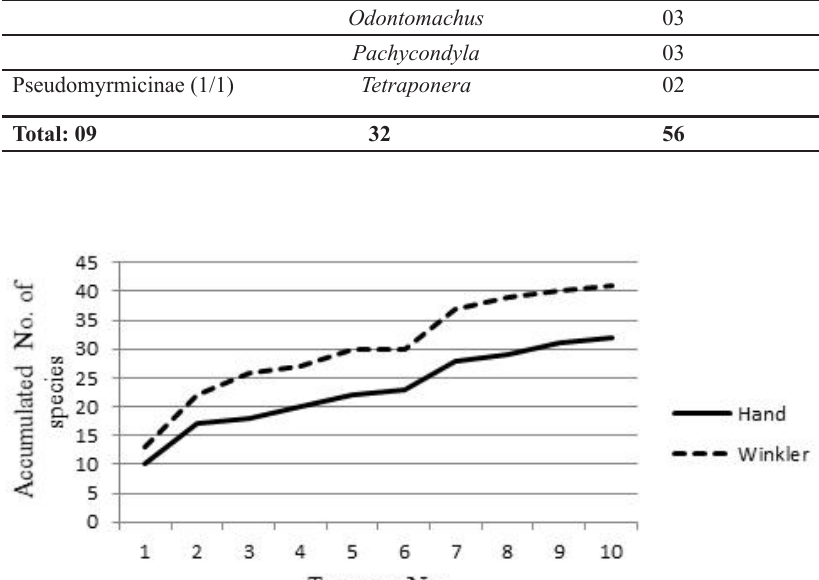
Figure 1: Species accumulation curves for the ants collected from the hand picking method and Winkler extraction method along the 10 transects installed along an elevation gradient in the Hanthana Forest